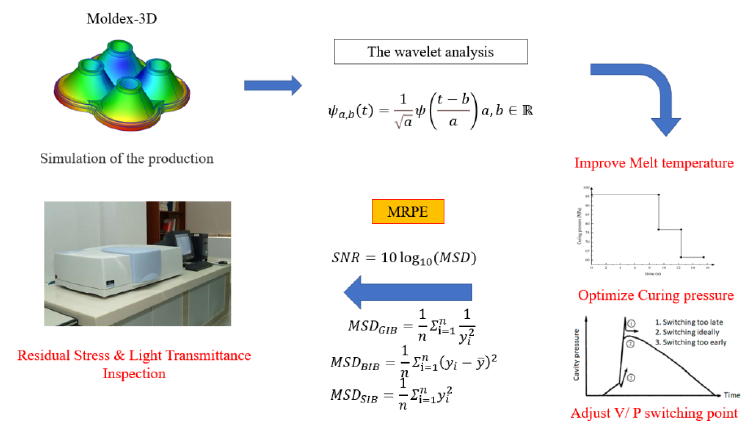
Figure 2. Concept for optical components experimental.